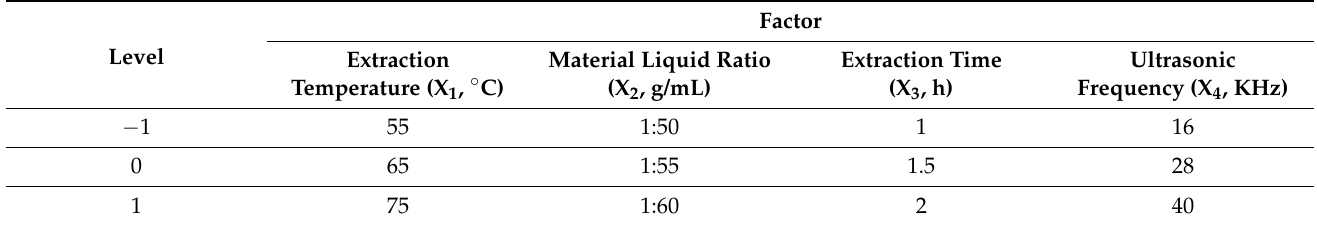
Table 5. Response surface test design.